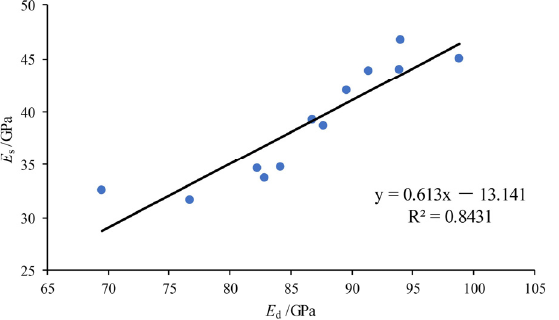
Figure 6. Plot showing the relationship between the dynamic ( E d ) and static ( E s ) Young’s modulus. Table 1. Data for rock mechanical parameters used in the numerical simulation. Strata